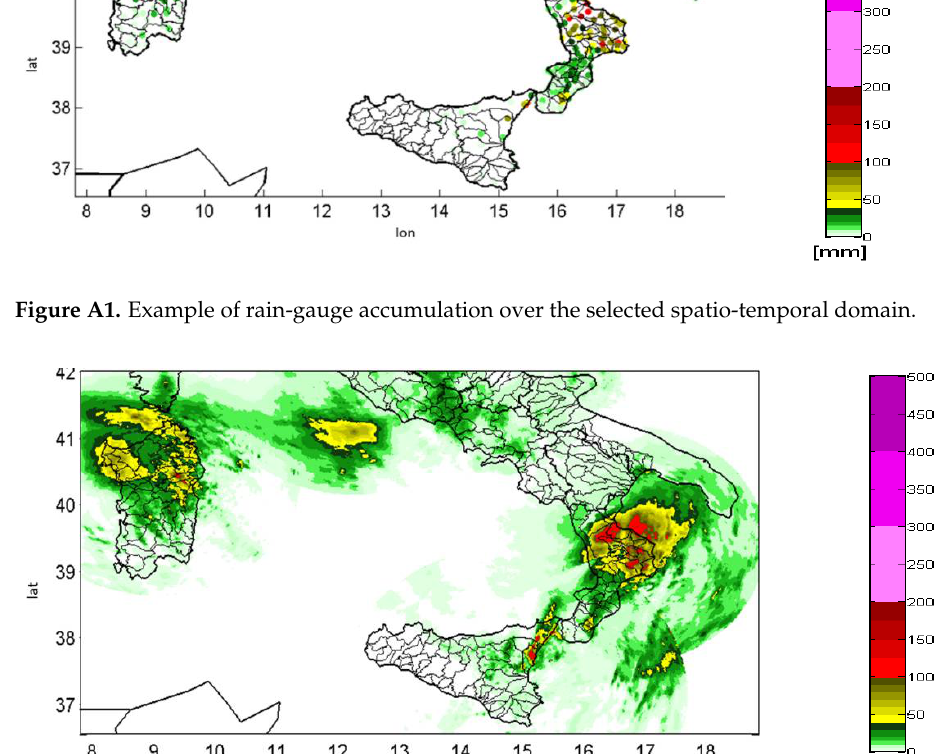
Figure A4. Example of fit of covariance kernel on the empirical 1D correlation.